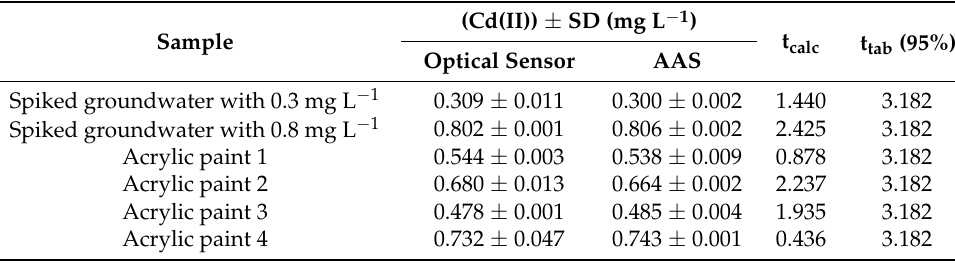
Table 3. Analysis of Cd(II) in real samples by the proposed optical sensor and AAS technique.